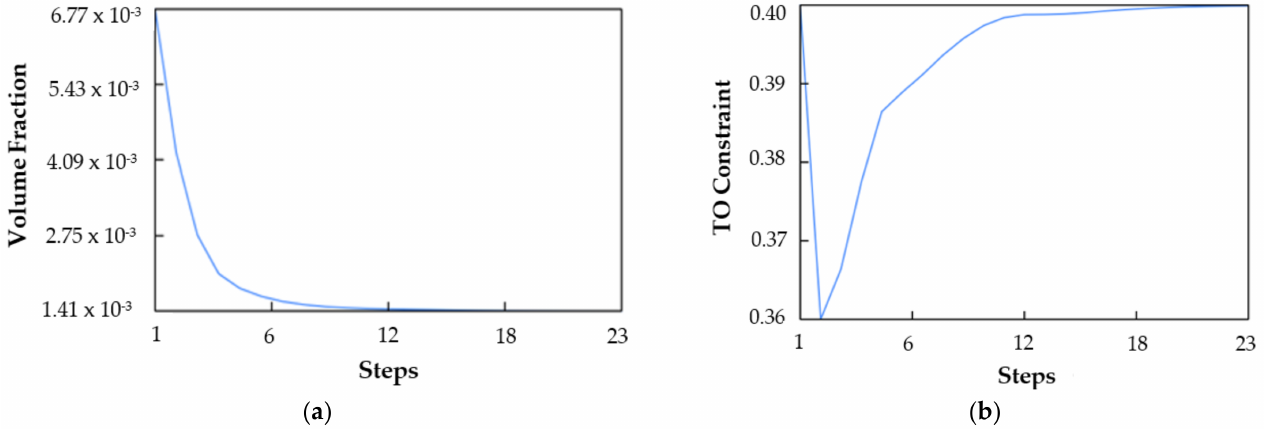
Figure 5. ( a ) Volume fraction per each step ( b ), and the value of the volume fraction constraints on each iteration step of ‘structure #1’.